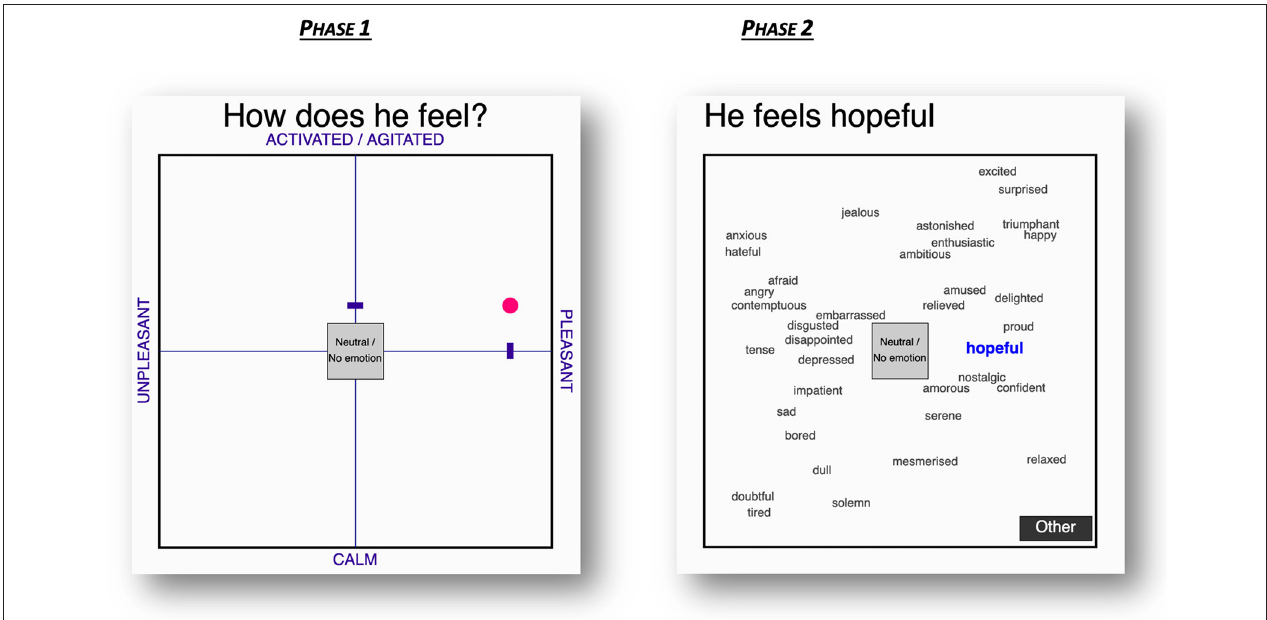
FIGURE 2 | First and second phases of the English version of the response